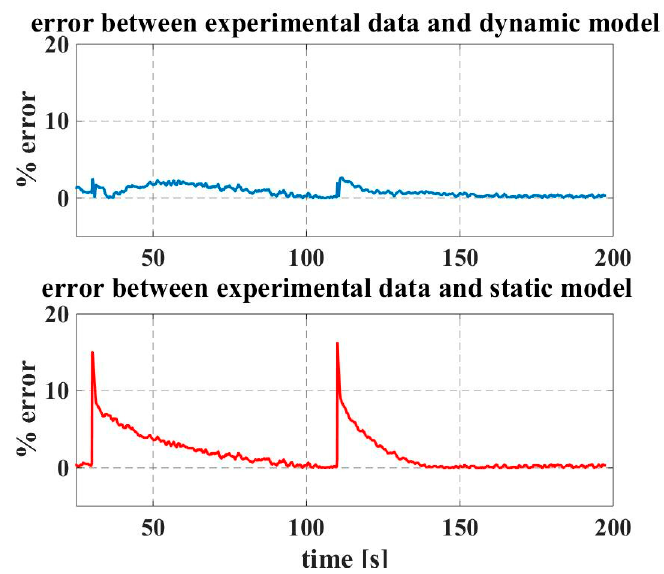
Figure 14. Error percentage obtained comparing the experimental data with the dynamic model ( top ) and the static model ( bottom ).